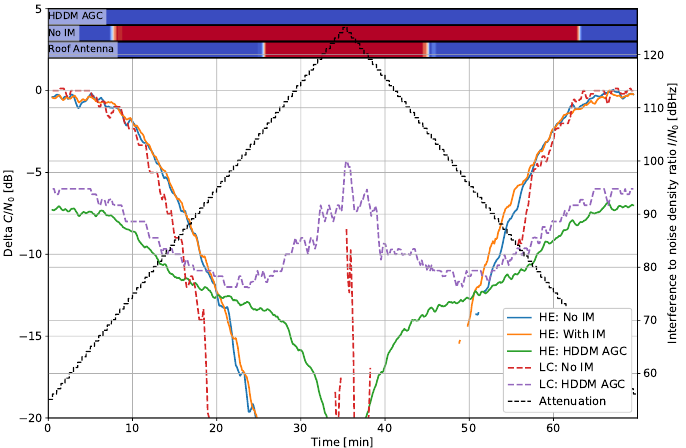
Figure 11. Interference #8: Delta C / N 0 for pulsed noise with 1 ms pulse width and 35 MHz